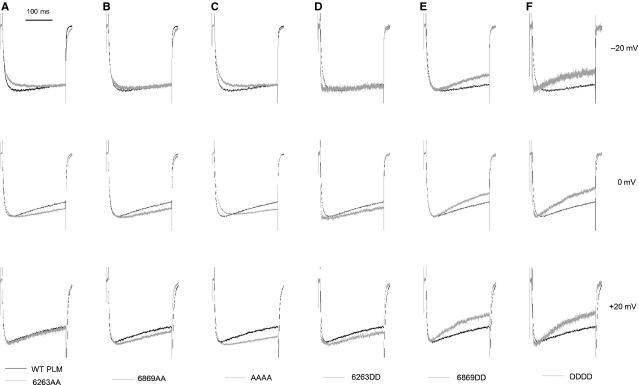
Amino acid substitutions at the PLM phosphorylation sites alter the CaV1.2 channel gating kinetics. (A–F) Whole-cell CaV1.2 currents recorded with WT PLM (black line) or mutant PLMs (grey line) were evoked by 300-msec. depolarizing steps from a holding potential of −90 mV to the voltages indicated on the right. The currents from 6 to 10 cells were normalized and averaged. Ba2+ was used as the charge carrier.